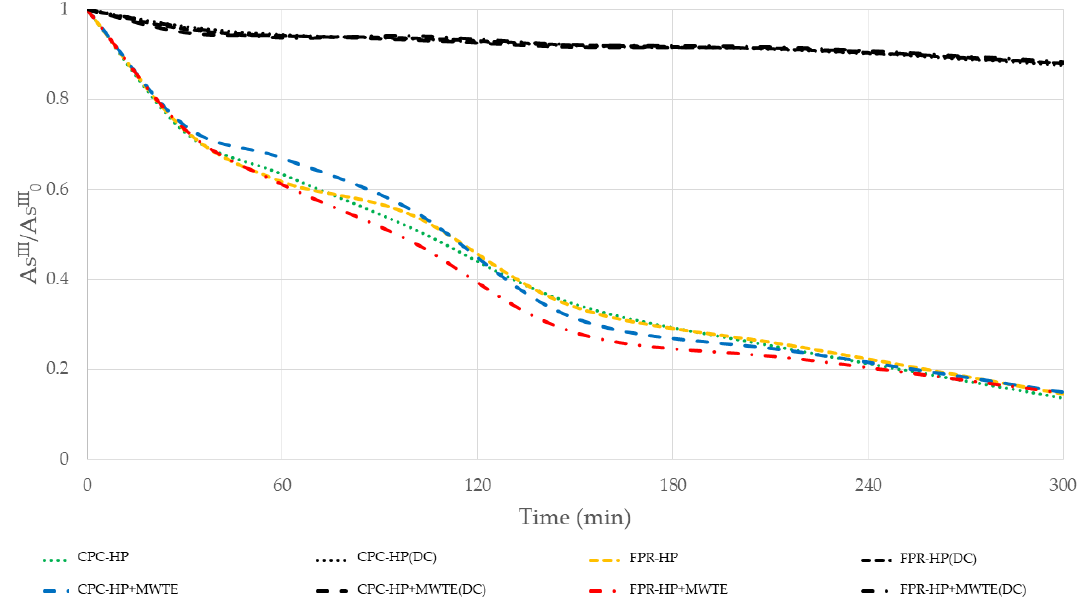
Figure 6. As III heterogeneous photocatalytic (HP) oxidation experiments carried out both in CPC and FPR, and with and without MWTE spike. Experiments performed in the dark as control experiments (DC) are included as well.